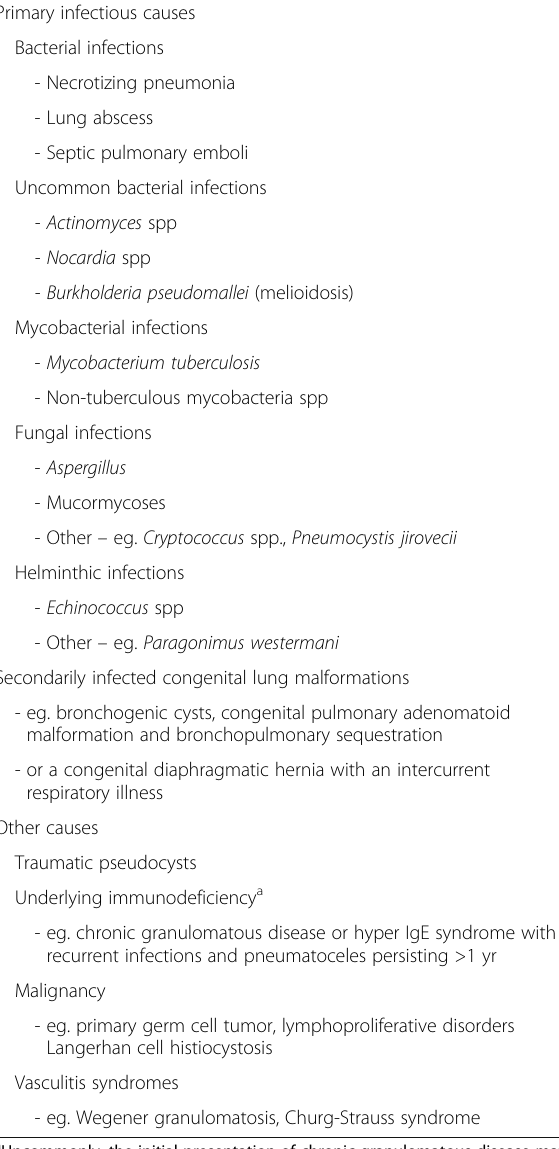
Table 3 Causes of pulmonary cavities in